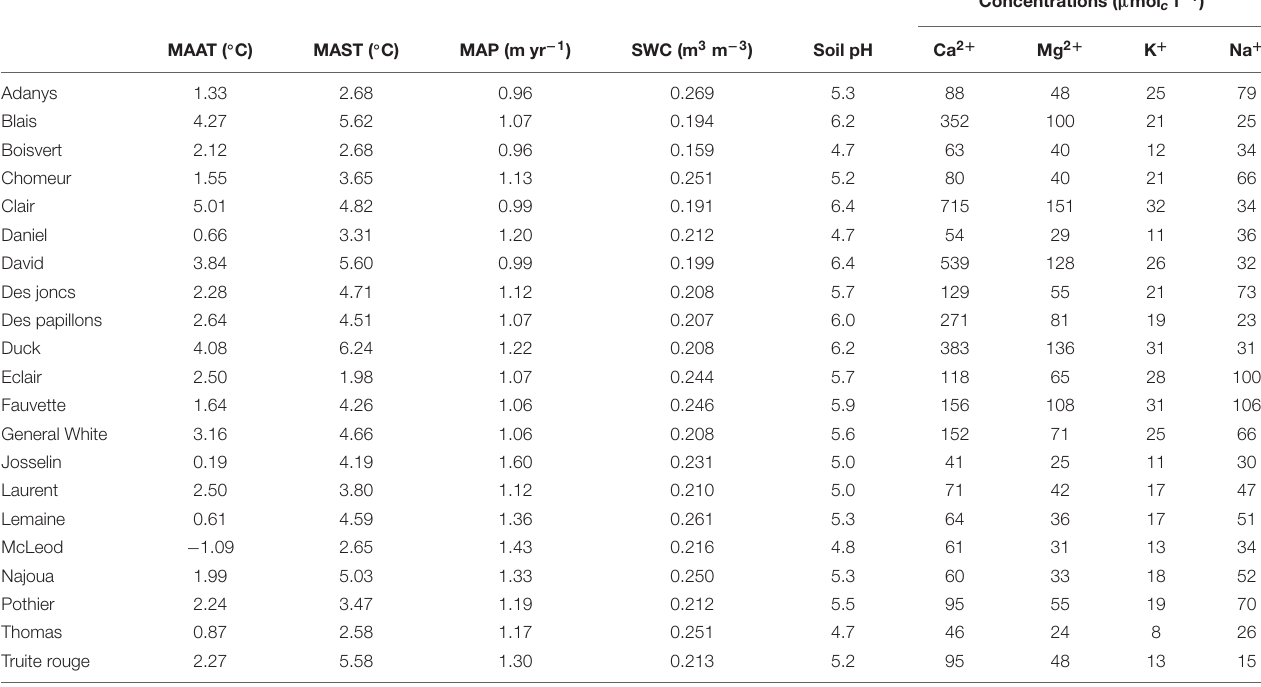
TABLE 1 | Sites characteristics for the reference period